Question: From the figure, is the trend upward or downward?
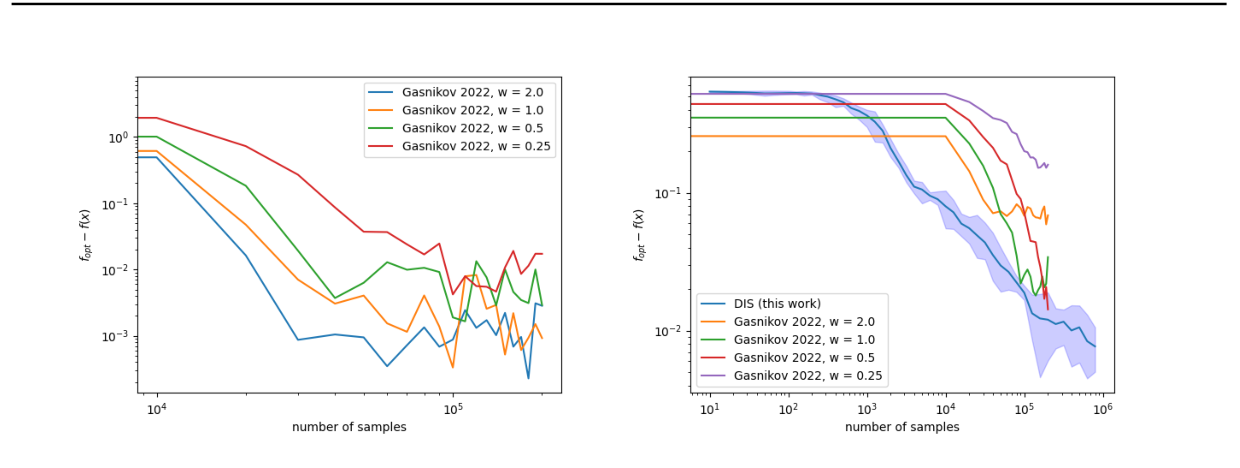
Answer: increasing